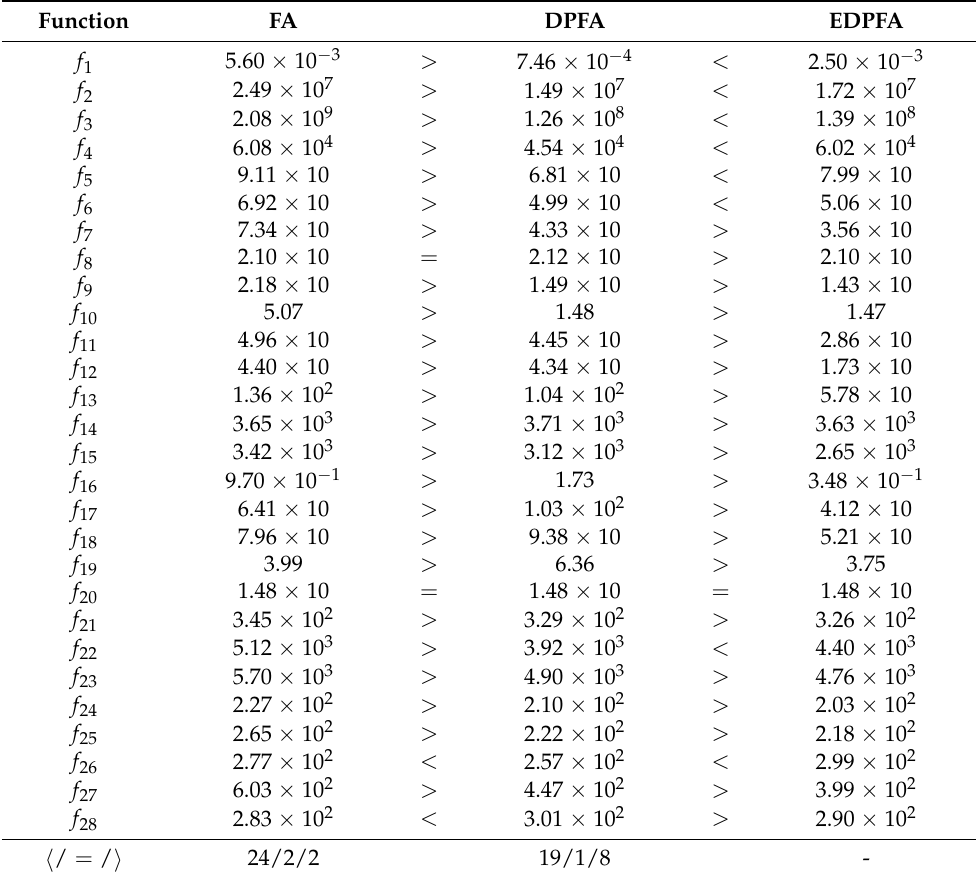
Table 3. Comparison of the EDPFA with the FA and DPFA.